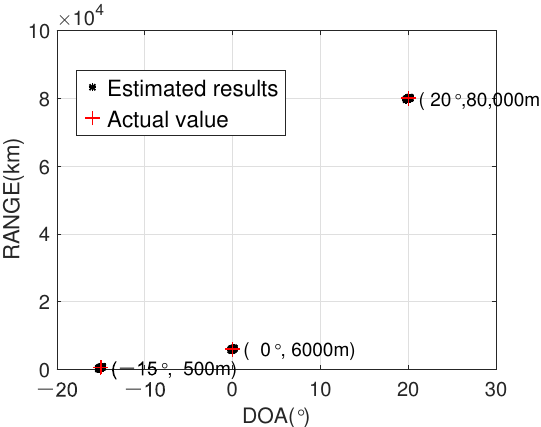
Figure 2. Target information estimation results, SNR = 20dB, L = 200.